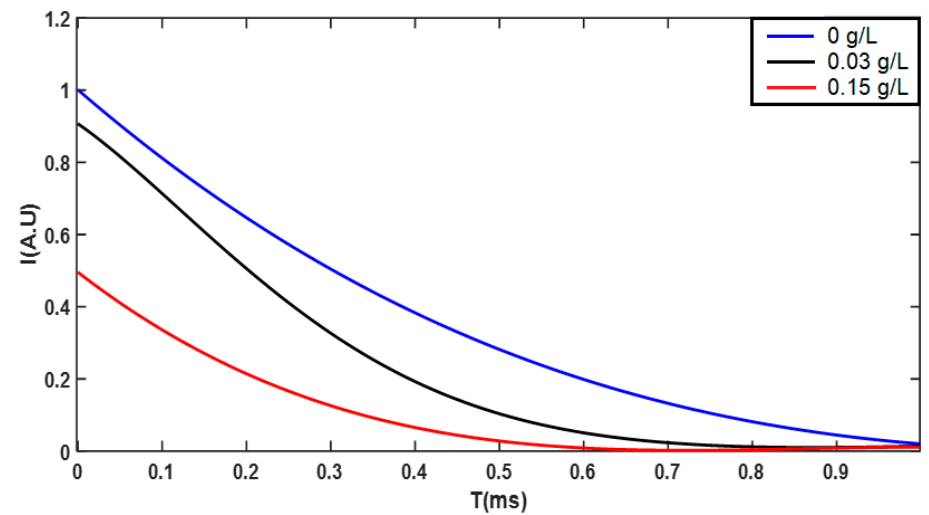
Figure 6. Fluorescence intensity lifetime variation of in-situ gold-ceria NPs due to increasing iron particle concentrations.